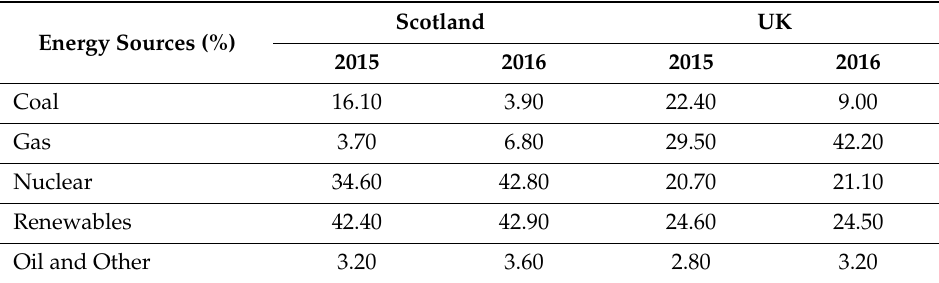
Table 3. Electricity generation by fuel type (Gov. UK, 2016).